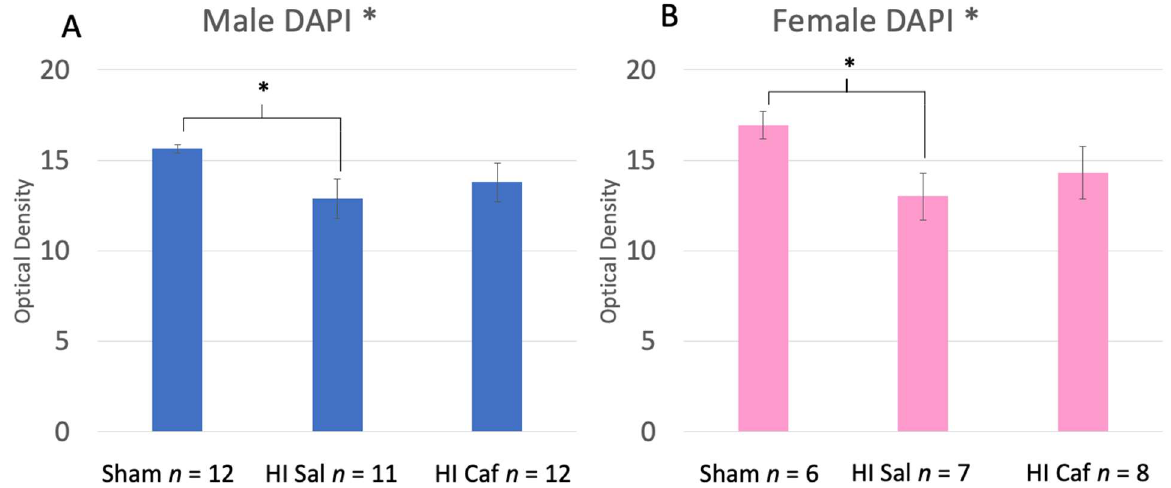
Figure 3. These two graphs display the DAPI results of the male ( A ) and female ( B ) animals. Sham refers to the animals that did not receive the HI procedure, HI Sal refers to animals that received the HI procedure but only received a saline treatment, and HI Caf refers to animals that received the HI procedure and were treated with caffeine. DAPI stain was used to measure chromatin condensation through optical density. The lower the optical density, the greater chromatin condensation and thus cell death (lower optical density indicates higher cell death). There was no Sex difference seen between Groups ( p = 0.456 but displayed separately to illustrate comparable protection). There was an overall Group difference ( p = 0.012), and based on a Tukey post-hoc analysis, a difference between HI saline and Sham animals ( p = 0.012) was seen. Though there is no significant difference between HI saline and HI caffeine animals, the lack of difference between HI caffeine and Sham animals supports a partial reduction in cell death in caffeine-treated animals at 48 h post injury. * indicates a p -value less than 0.05.